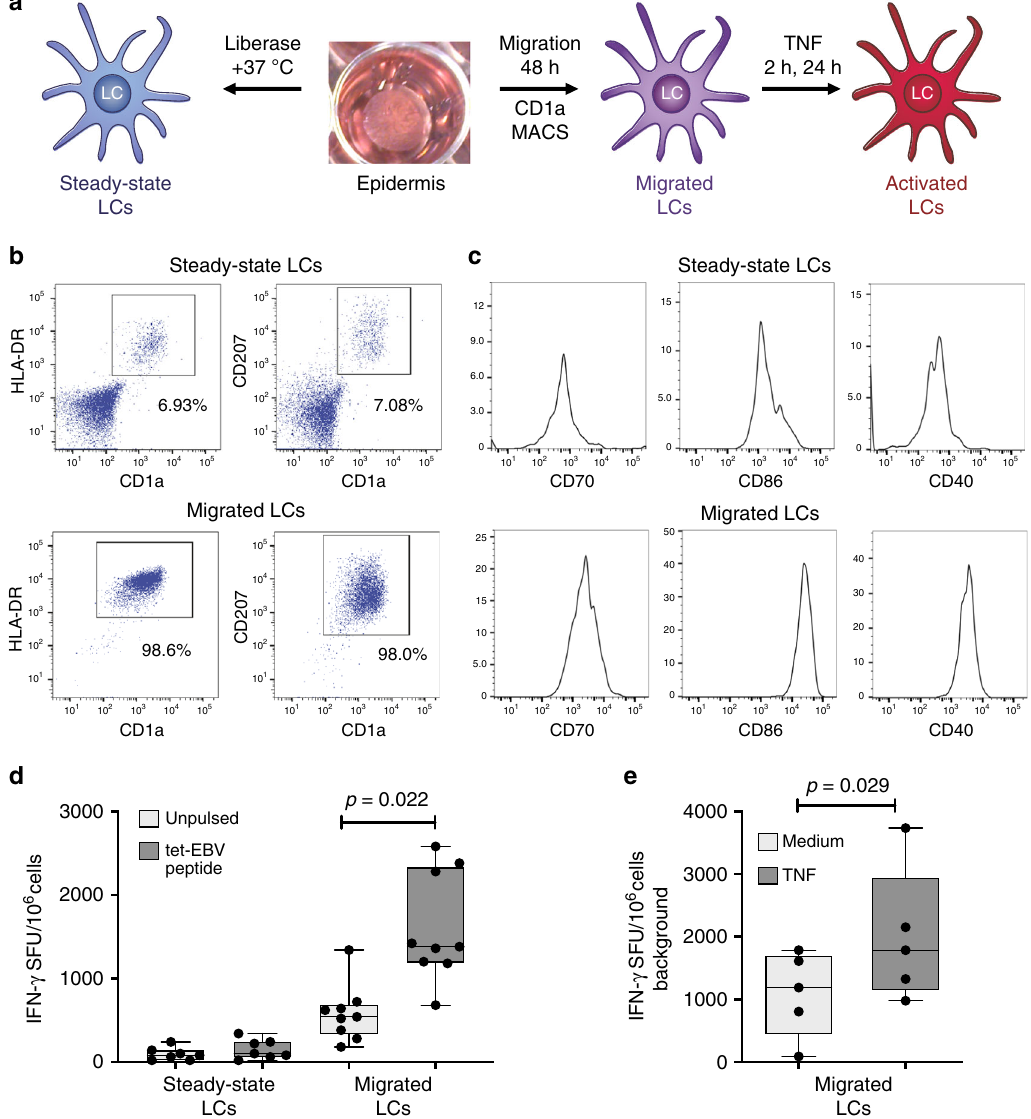
Fig. 1 System for analysing human LCs and control of antigen cross-presentation. a Schematic depicting isolation of primary human LCs. Split healthy skin was treated with dispase for 20 h to dissociate epidermis. Steady-state LCs were isolated from the epidermis by digestion with liberase TM or migrated from the epidermal sheets for 48 h in cell culture medium and stimulated with TNF (24 h) to induce their activation. b Flow cytometry assessment of steady-state and migrated LC. LCs were enumerated as CD207/CD1a/HLA-DR high cells. A representative example of n > 5 independent donors. c Flow cytometry assessment of activation markers expressed by steady-state and migrated LC. Co-stimulatory molecules critical for T-cell activation during antigen presentation (CD70, CD86 and CD40) were analysed in CD207/CD1a/HLA-DR high cells. A representative example of n > 5 independent donors. d IFN- γ secretion by an EBV-speci fi c CD8 T-cell line stimulated with antigen presenting LCs in the context of MHC-I HLA-A2. Steady- state or migrated LCs were pulsed with 30-amino acid peptides containing EBV epitope (dark grey). Pulsed or unpulsed (light grey) LCs were stimulated with TNF and then assayed for IFN- γ secretion. ELISpot assay, n = 5 independent experiments in triplicate, paired t test, box and whiskers show min and max value, line at median. Source data are provided as a Source Data fi le. e IFN- γ secretion by EBV-speci fi c CD8 T-cell line stimulated by migrated LCs pulsed as in panel d . IFN- γ secretion was measured with (black) or without (grey) TNF stimulation. ELISpot assay, n = 5 independent experiments in triplicate, paired t test, box and whiskers show min and max value, line at median. Source data are provided as a Source Data fi le.